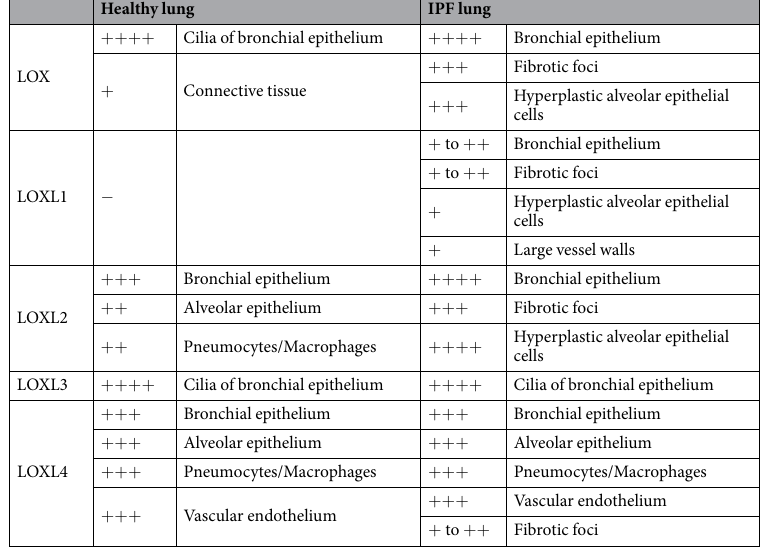
Table 1. LOX/L family protein expression in human lung